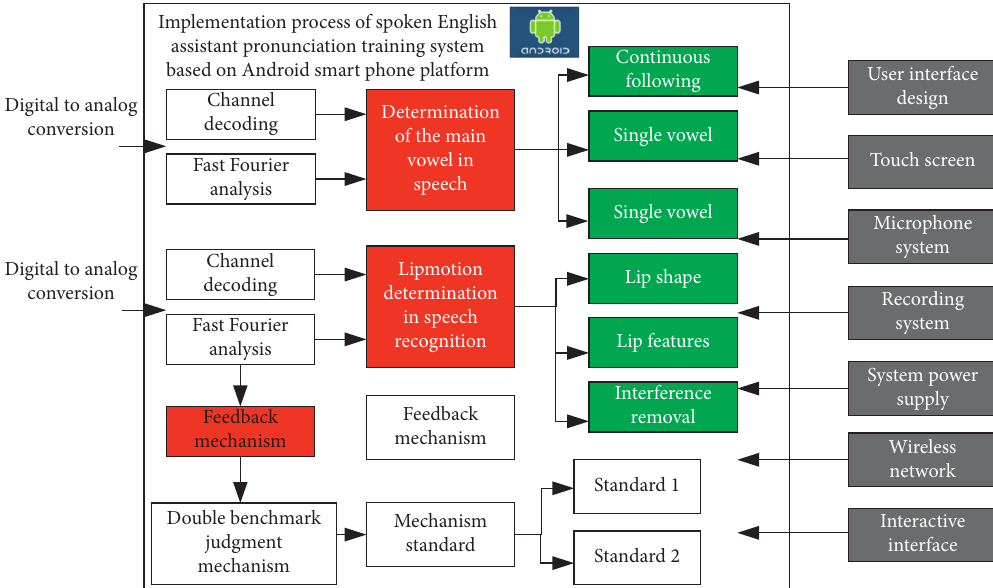
Figure 6: Implementation block diagram of spoken English assistant pronunciation training system based on Android smartphone platform.